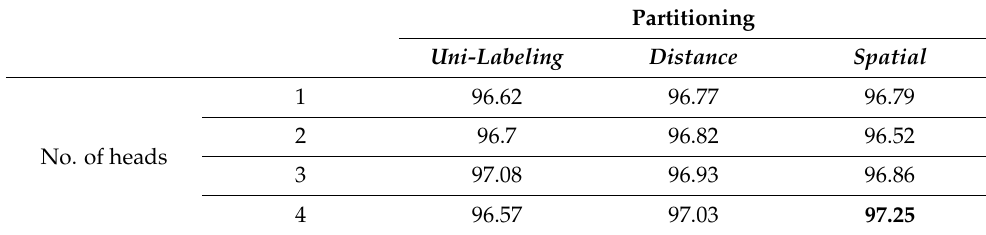
Table 2. Results (% accuracies) of the hyperparameters’